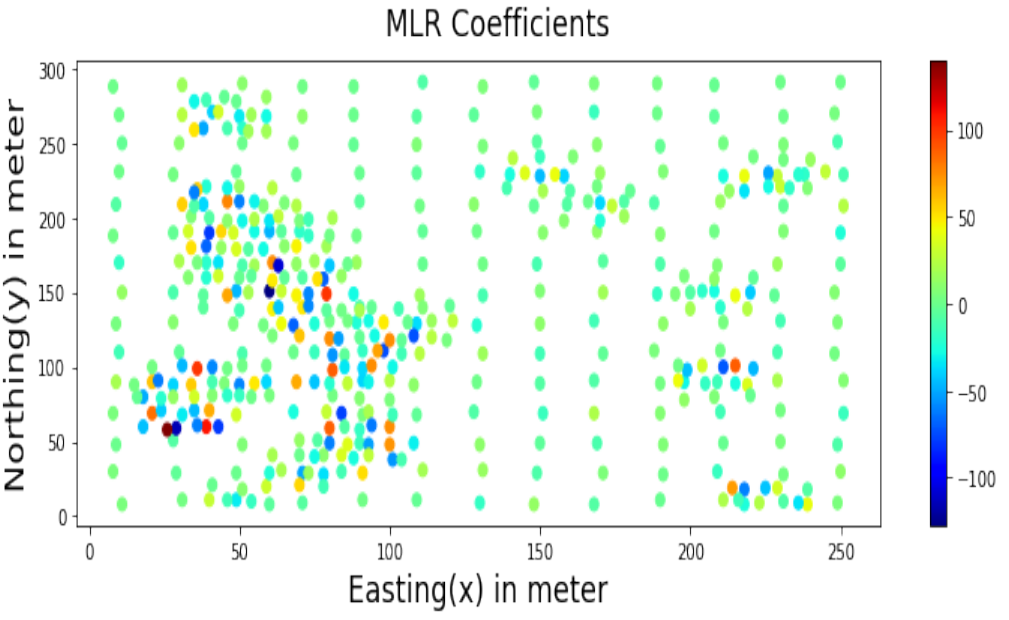
Figure 14. MLR Coefficients for prediction using Walkerlake dataset.